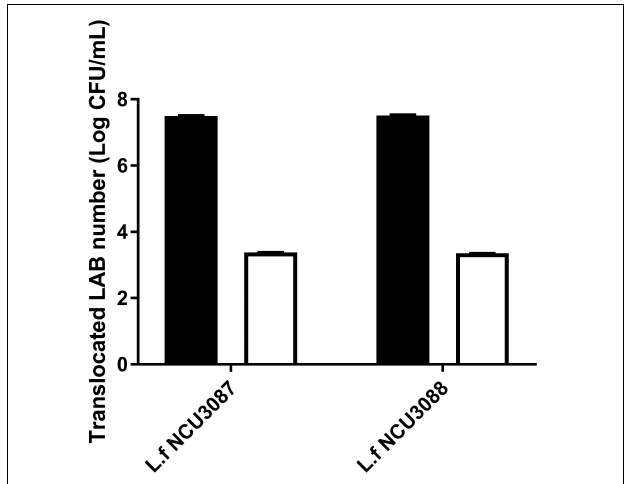
FIGURE 6 | Translocation of two lactobacilli in the Caco-2 monolayer model. (cid:4) Initial LAB number, (cid:3) translocated LAB number. The experiments were performed in triplicate, and they are mean ±